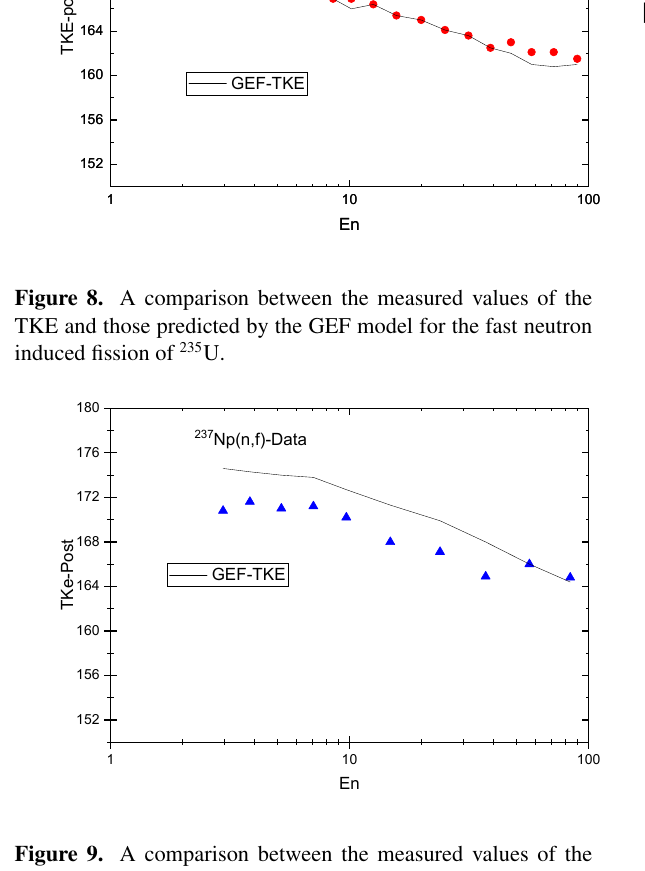
Figure 9. A comparison between the measured values of the TKE and those predicted by the GEF model for the fast neutron induced fission of 237